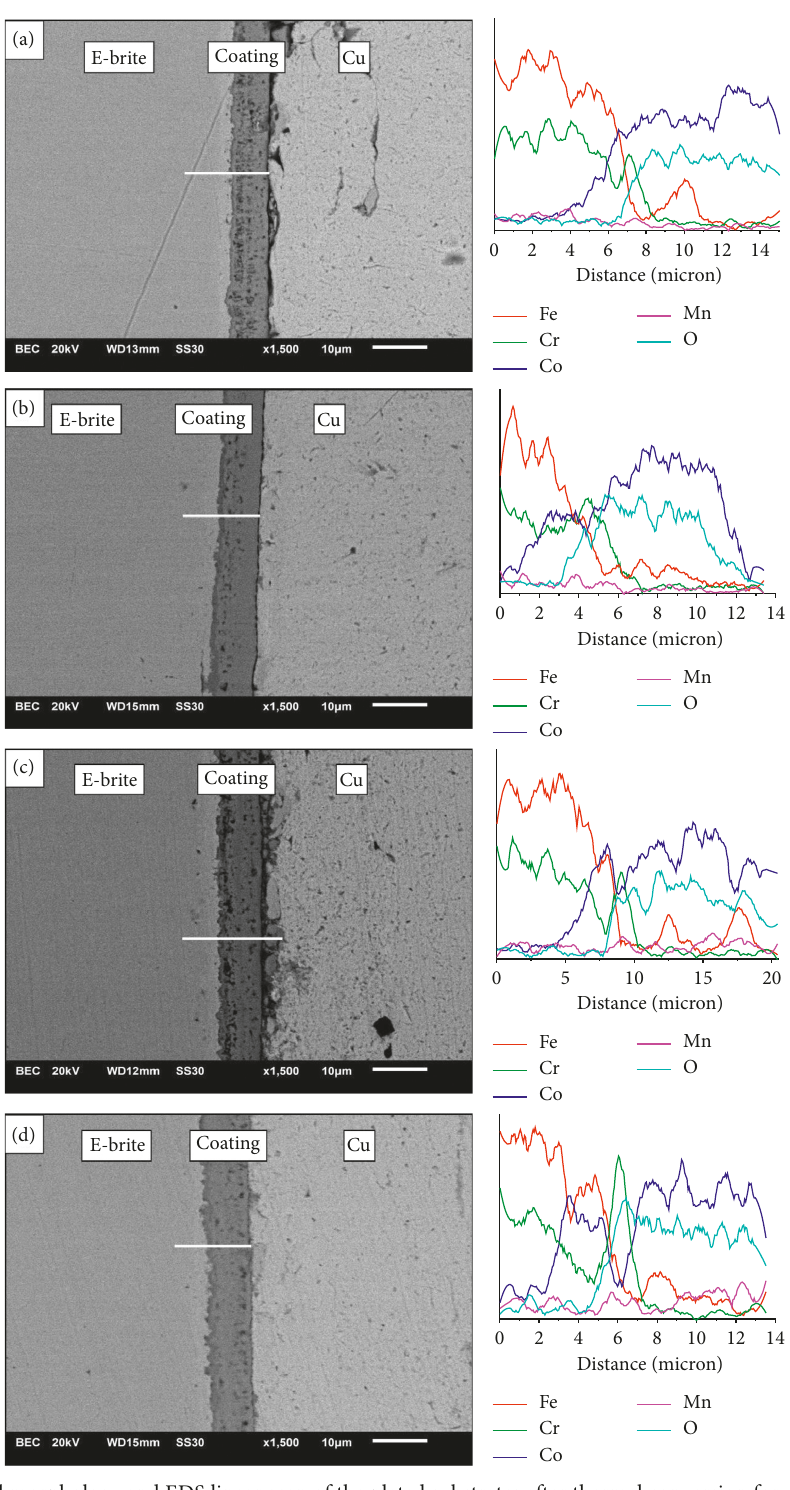
Figure 6: Cross-sectional morphology and EDS linear scan of the plated substrates after thermal conversion for different times: (a) the Co coating for 10min; (b) the Co coating for 4 h; (c) the Co-Mn 3 O 4 coating for 10 min; and (d) the Co-Mn 3 O 4 coating for 4